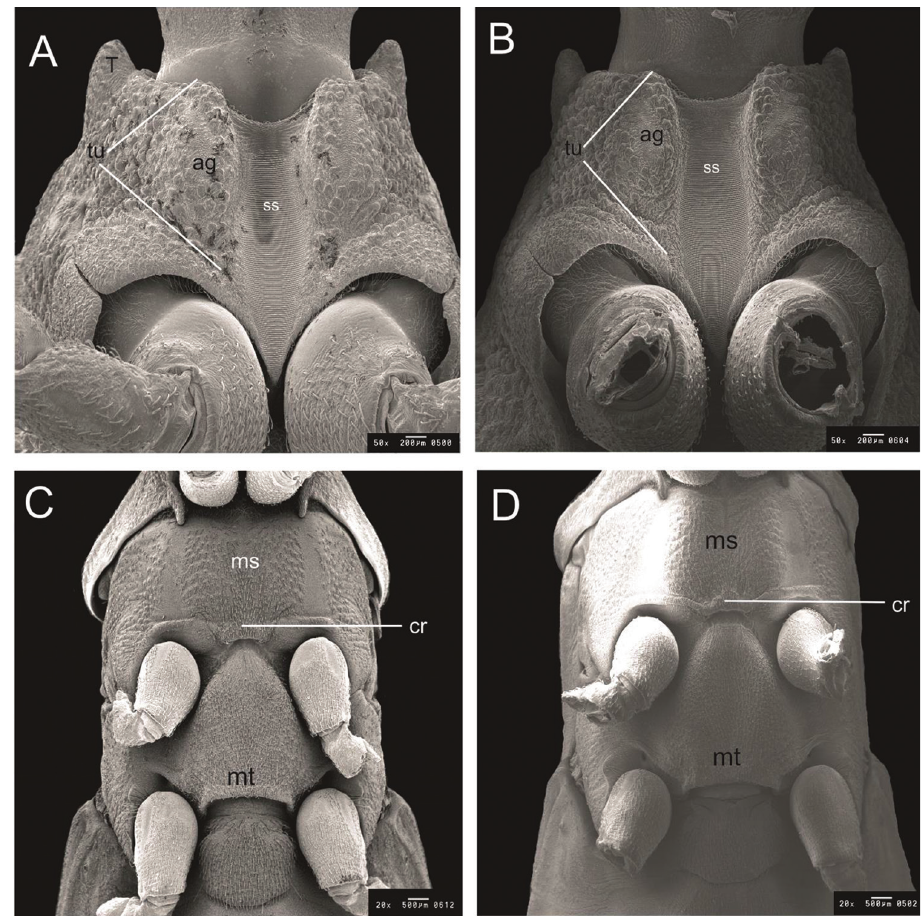
Figure 5. Thorax ventral by SEM. A, C R. taquarussuensis sp. n. B, D R. neglectus . ss: stridulatory sulcus, ms: mesosternum, mt: metasternum, tu: tubercle, ga: glabrous area, cr: central region.